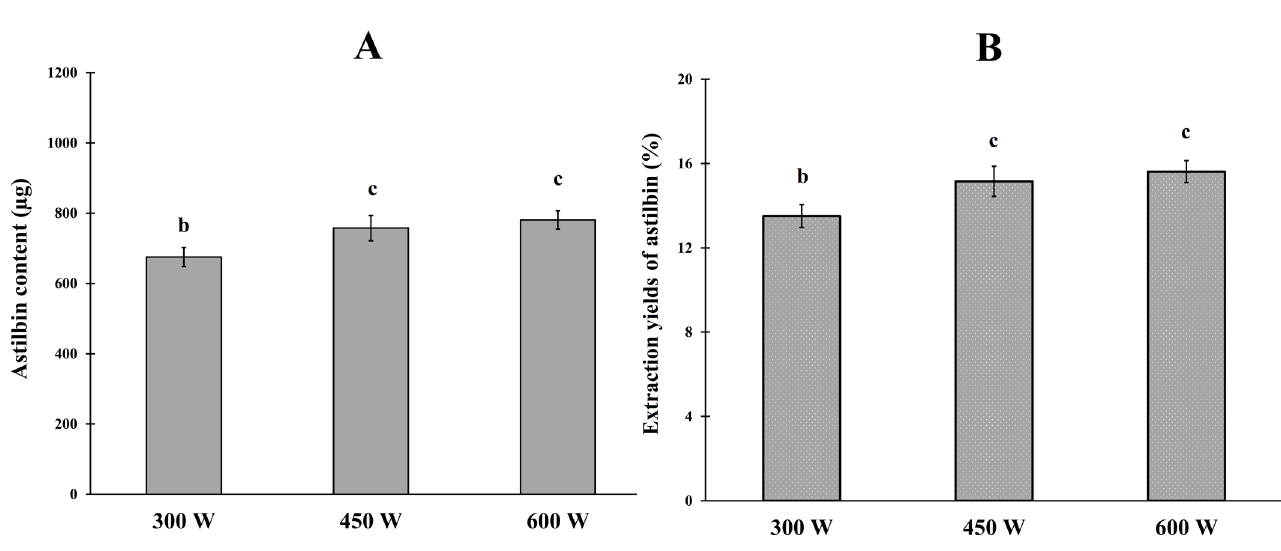
FIGURE 5 - (A) Astilbin content and (B) extraction yields of astilbin at different microwave power levels (300, 450, and 600 calculated as dry powder of L. strychnifolium stem. b significantly different ( p < 0.05 ). c significantly different ( p > 0.05